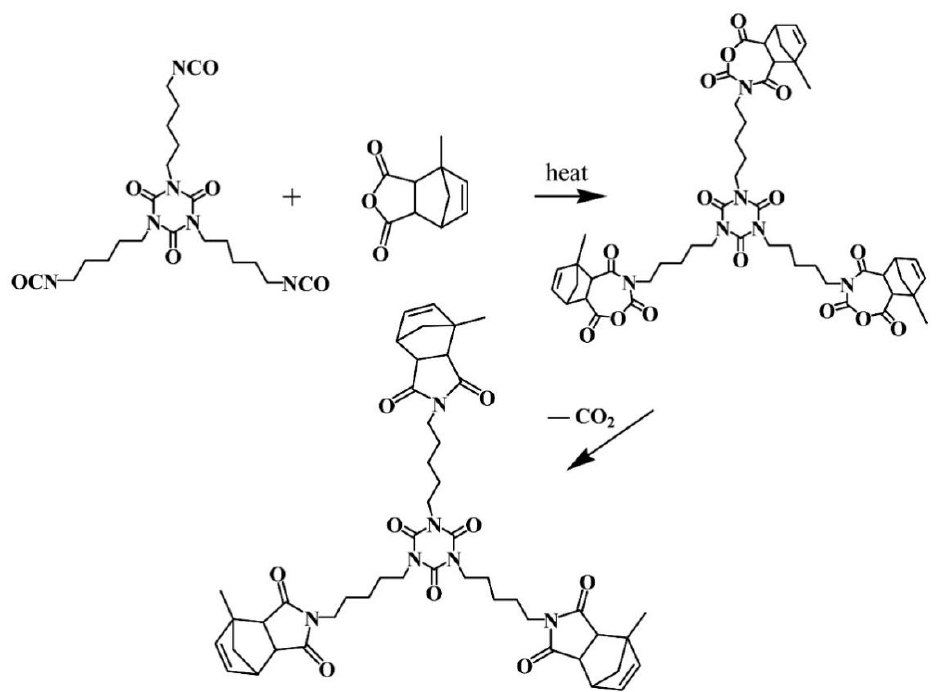
Figure 2. Synthesis reaction of HBPI.